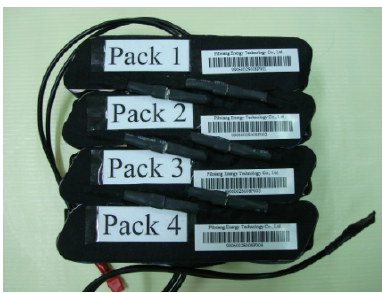
battery packs (2S8P × 4